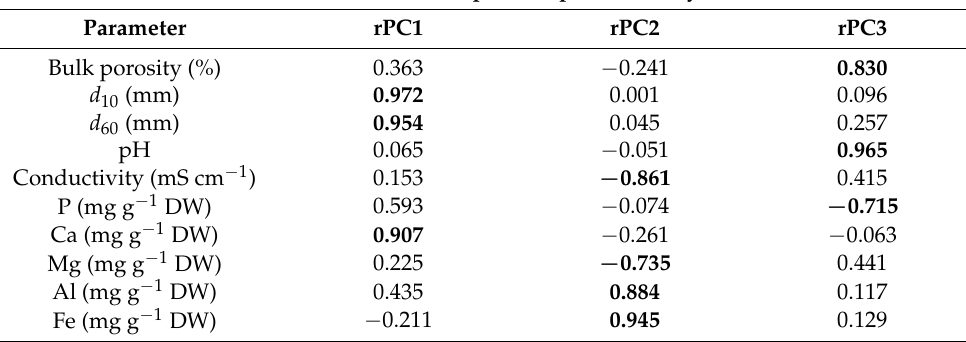
Boldface type indicate variables with high